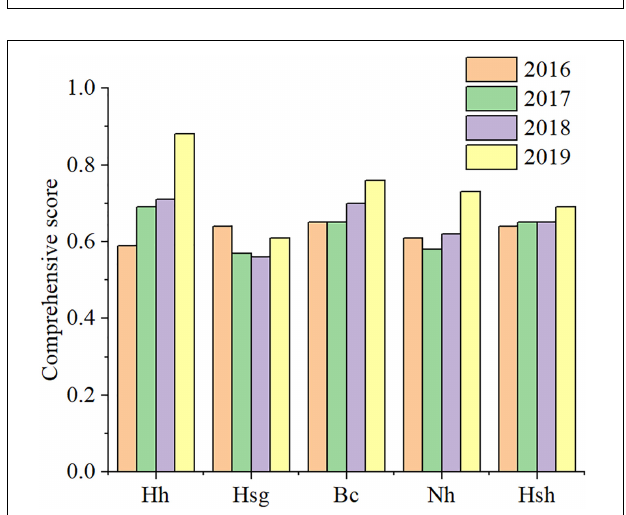
FIGURE 4 | Spatial distribution of the comprehensive health score of the Huangshui wetland based on the PSR-BP neural network. Hh (Haihu Wetland); Hsg (Huoshaogou Wetland); Bc (Beichuan Wetland); Nh (Ninghu Wetland); Hsh (Huangshuihe Wetland). Yellow represents 2016; pink represents 2017; green represents 2018; blue represents